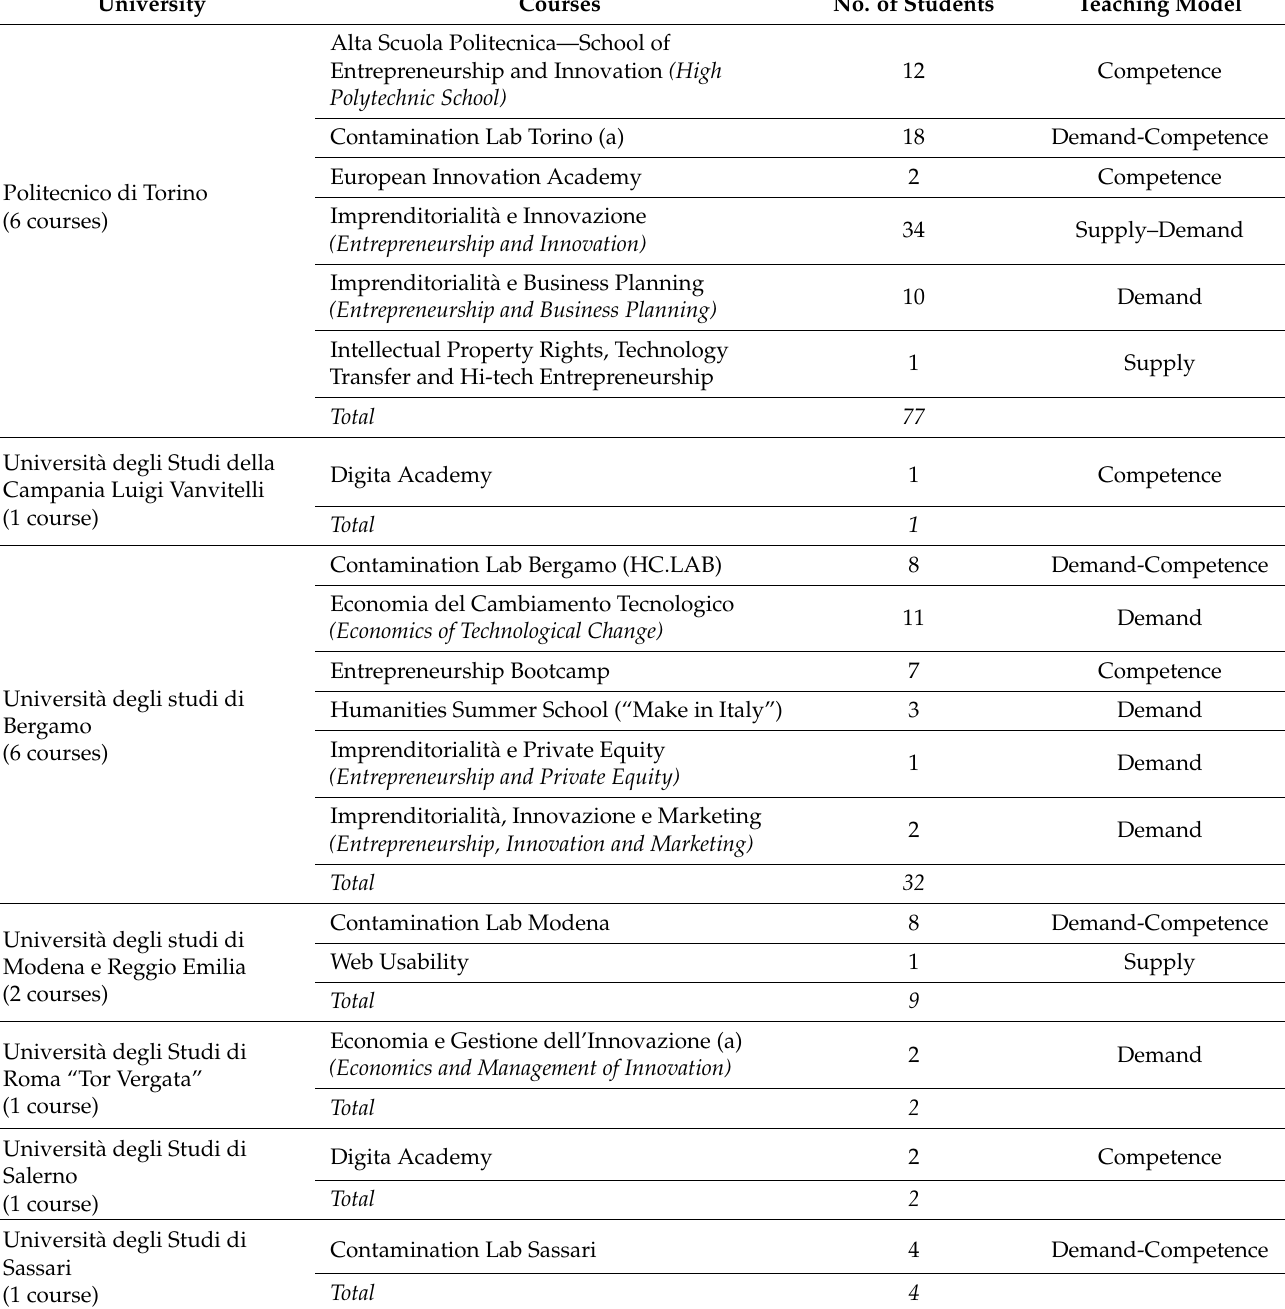
Table 3. Breakdown of courses by teaching